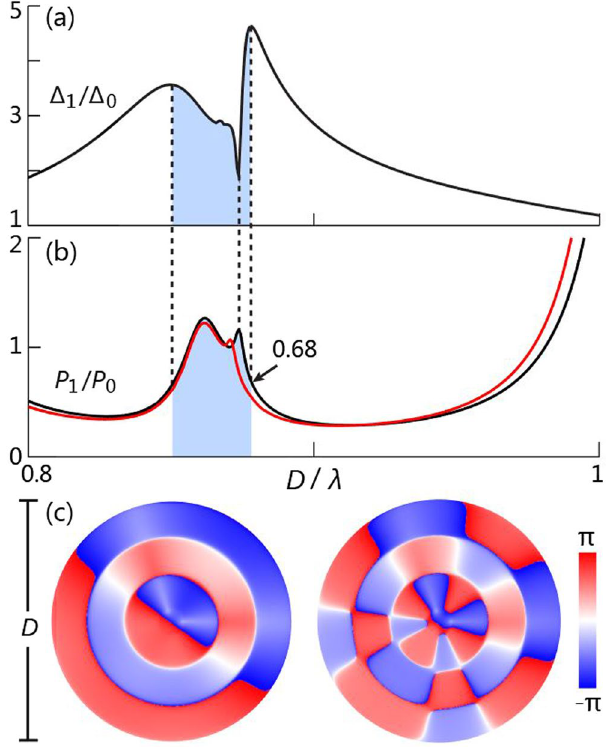
Figure 2. ( a ) Directivity enhancement Δ 1 / Δ 0 for the in-phase sources at P1 and P2, where Δ 1 ( Δ 0 ) is the directivity indicator with (without) the enclosure (See Eq. (2)). The local maxima and minima of Δ 1 / Δ 0 are indicated by the vertical dashed lines. ( b ) P 1 / P 0 is the ratio of radiated power, where P 1 ( P 0 ) is the power with (without) the enclosure. In ( b ), the black curve is the simulation result in the case with the enclosure. P 1 / P 0 is 0.68 when Δ 1 / Δ 0 reaches maximum. The red curve is the simulation result with the enclosure’s effective medium. The two local peaks of P 1 / P 0 happen at resonances, whose phase distribution is shown in ( c